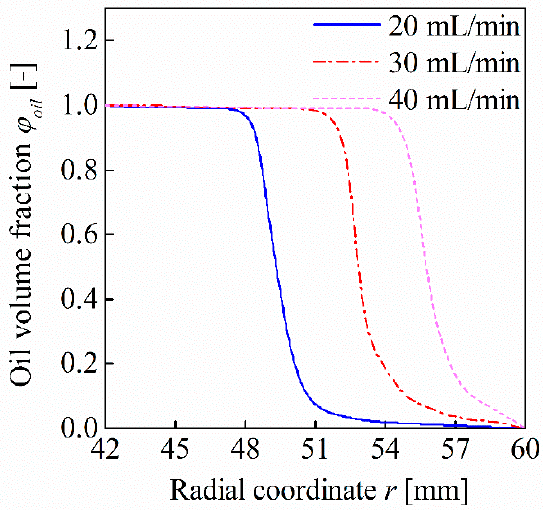
Figure 8. Average oil volume fraction curves at different radial positions with different oil flow rates.